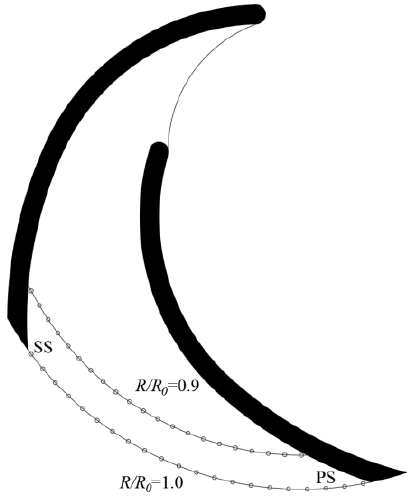
Figure 7. The locations of the different sampling lines.